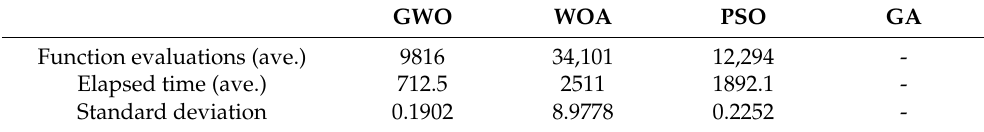
Table 10. Statistical results of the performance of each algorithm in all runs. GWO WOA PSO GA Function evaluations (ave.) Elapsed time